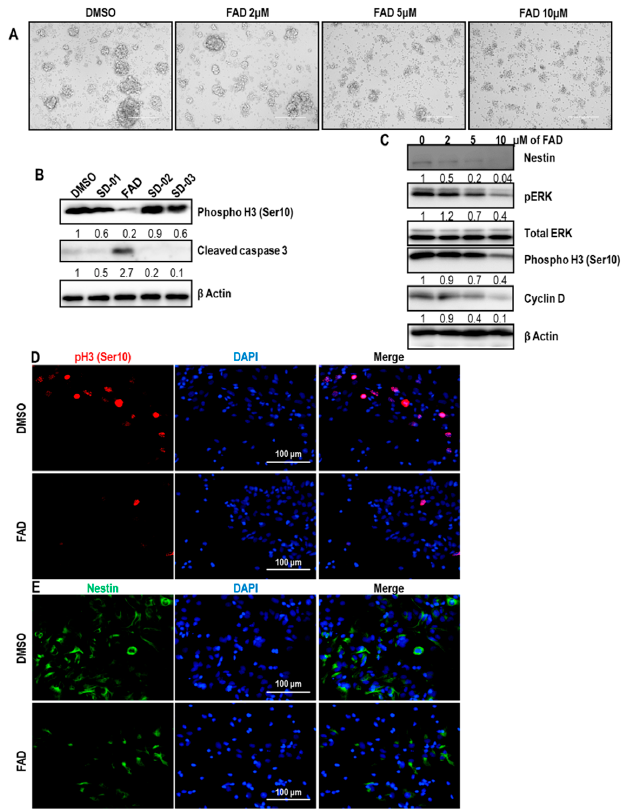
Figure 3. Disruption of the cellular maintenance by FAD in normal neural stem cells